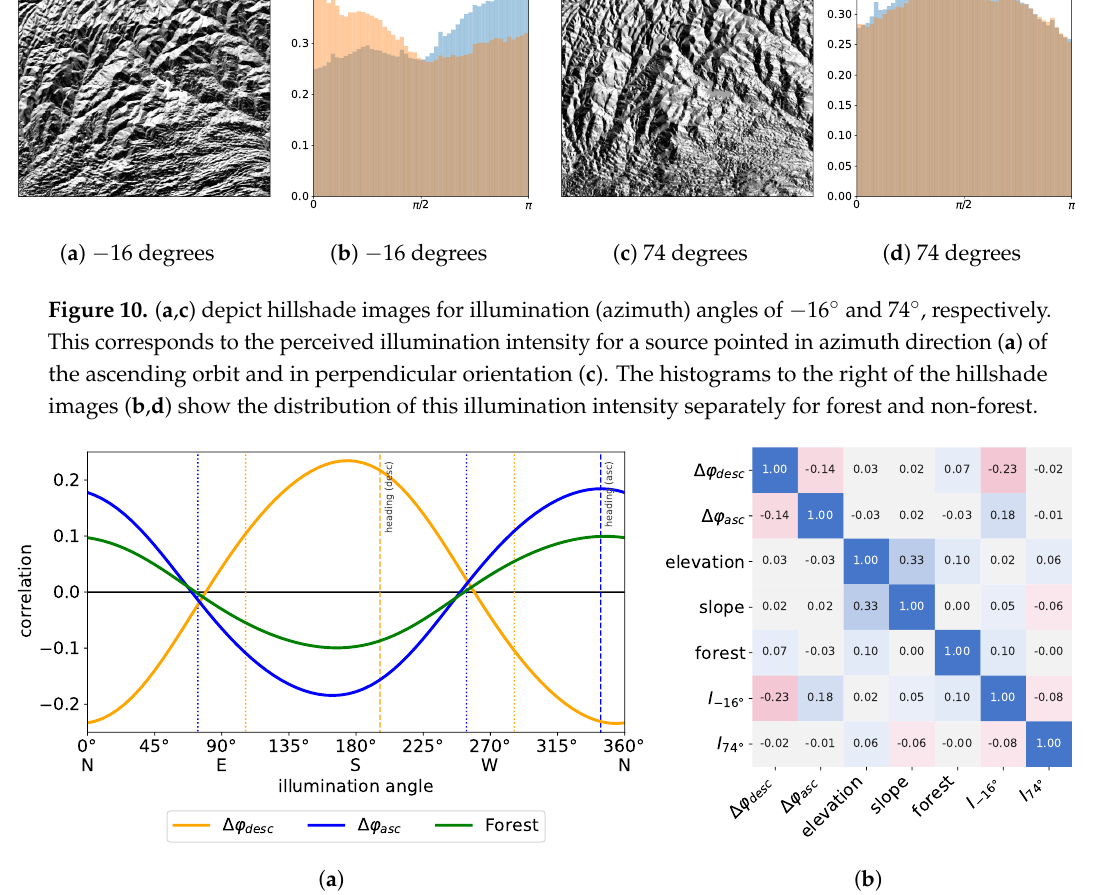
Figure 11. The figure on the left ( a ) shows the correlation between a simulated hillshade image of the UK study site and the mean VV-VH phase difference in ascending and descending orbit as well as the forest cover for different illumination angles. Dashed and dotted lines indicate the heading angle and perpendicular directions, respectively. The figure on the right ( b ) shows the correlation between different variables in matrix form. I θ denotes the hillshade with illumination angle θ